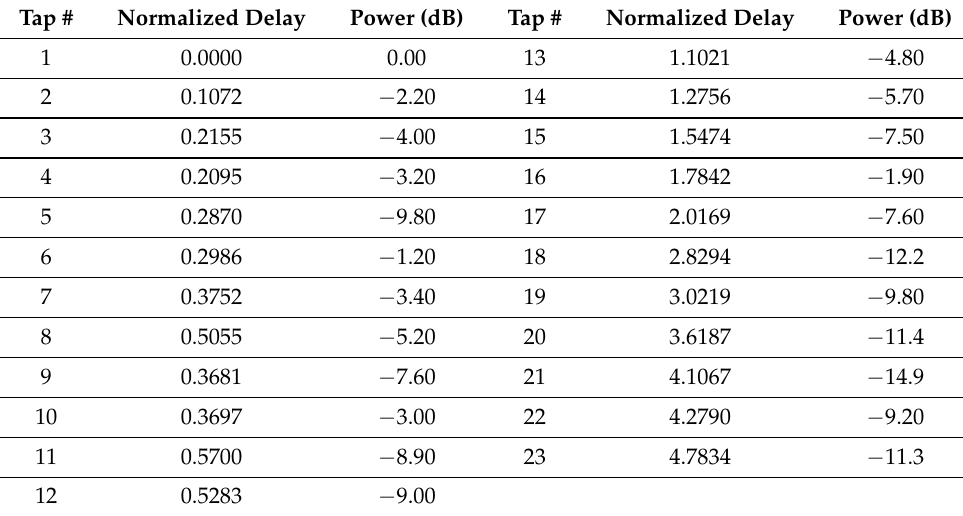
Table 1) for the channel model simulated in this work. Table 1. Table 7.7.2-2.